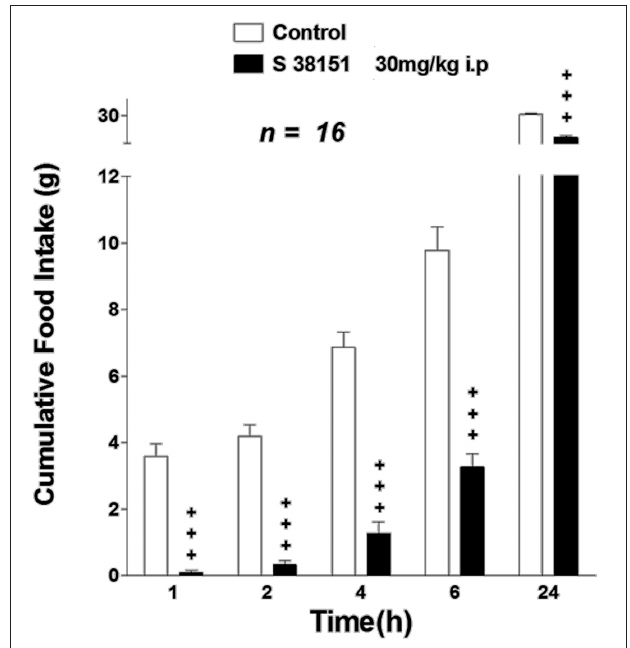
FIGURE 6 | The effect of S38151 on food intake in Zucker fa/fa rats after acute peripheral administration. Rats were fasted for 24h, and then injected (i.p.) at the beginning of the light phase with vehicle (normal saline) or 30mg/kg S38151. Cumulative food intake was measured 1, 2, 4, 6, and 24h after injection. Results are expressed as mean ± SEM ( n = 16 rats per group). Repeated measures Two-Way ANOVA (treatment × time) was followed by post hoc Student-Neuman-Keulsanalysis to compare all groups of animals. + P < 0 .